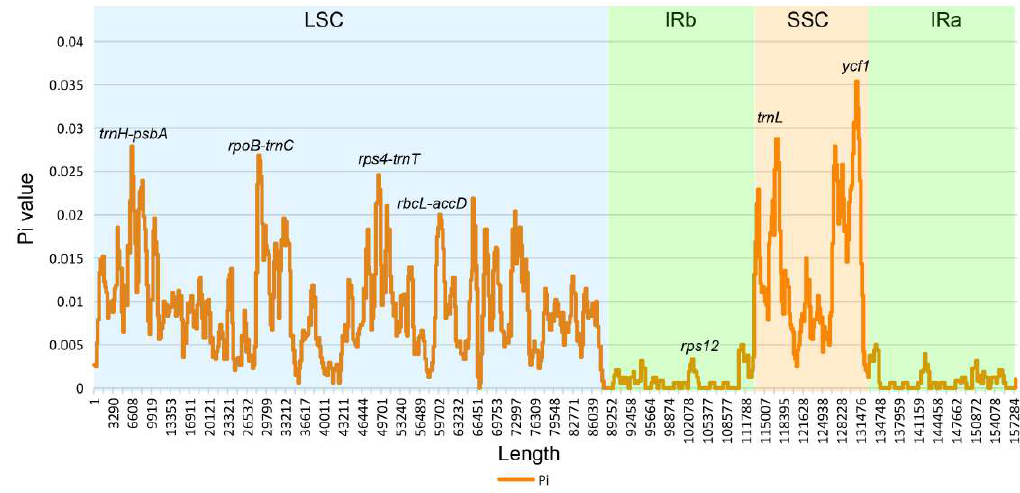
Figure 5. Nucleotide diversity ( π ) values among the Benincaseae species.